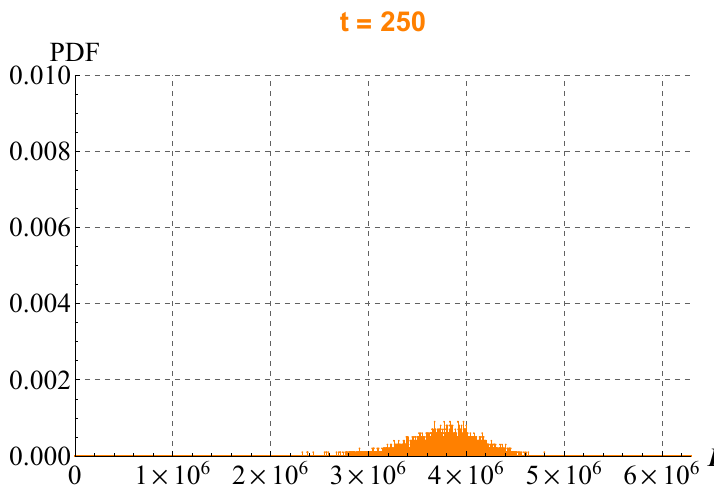
Figure 33. USA-Three-Waves Model. US-PDF after 250